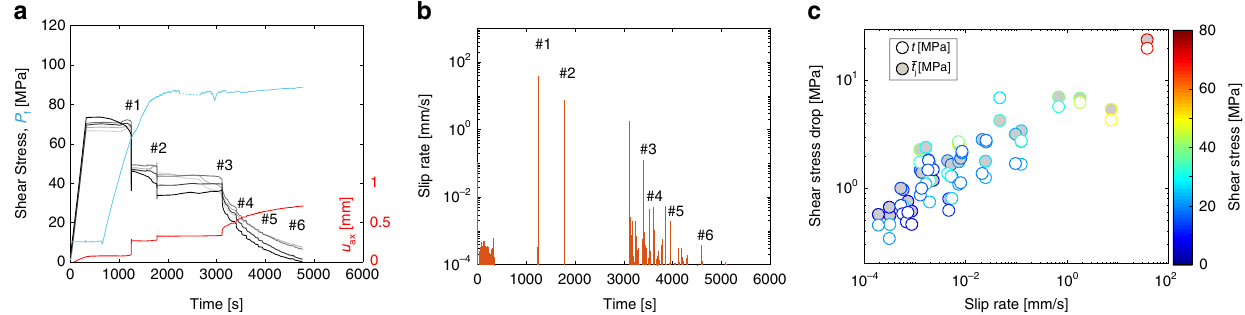
Fig. 3 Transition from fast to slow slip events. a Mechanical results obtained during the experiment conducted at 95 MPa con fi ning pressure. The evolution of the local shear stress along the fault at each strain gage location as a function of time is displayed by the grey-to-black solid lines. The evolution of the average slip along the fault is displayed by the red solid line and the evolution of the fl uid pressure in the injection site by the cyan solid line. b Slip velocity burst associated with each slip instability. The peak slip velocity reached during instability decreases over time, i.e., with an increasing number of events and with the progressive release of the initial shear stress. Numbers displayed in a and b refer to events for which the slip front propagation is presented in Fig. 4. c Scaling relation between the shear stress drop versus average slip rate obtained using the average stress pro fi le recorded by strain gages (grey circles) or pressure sensors (white